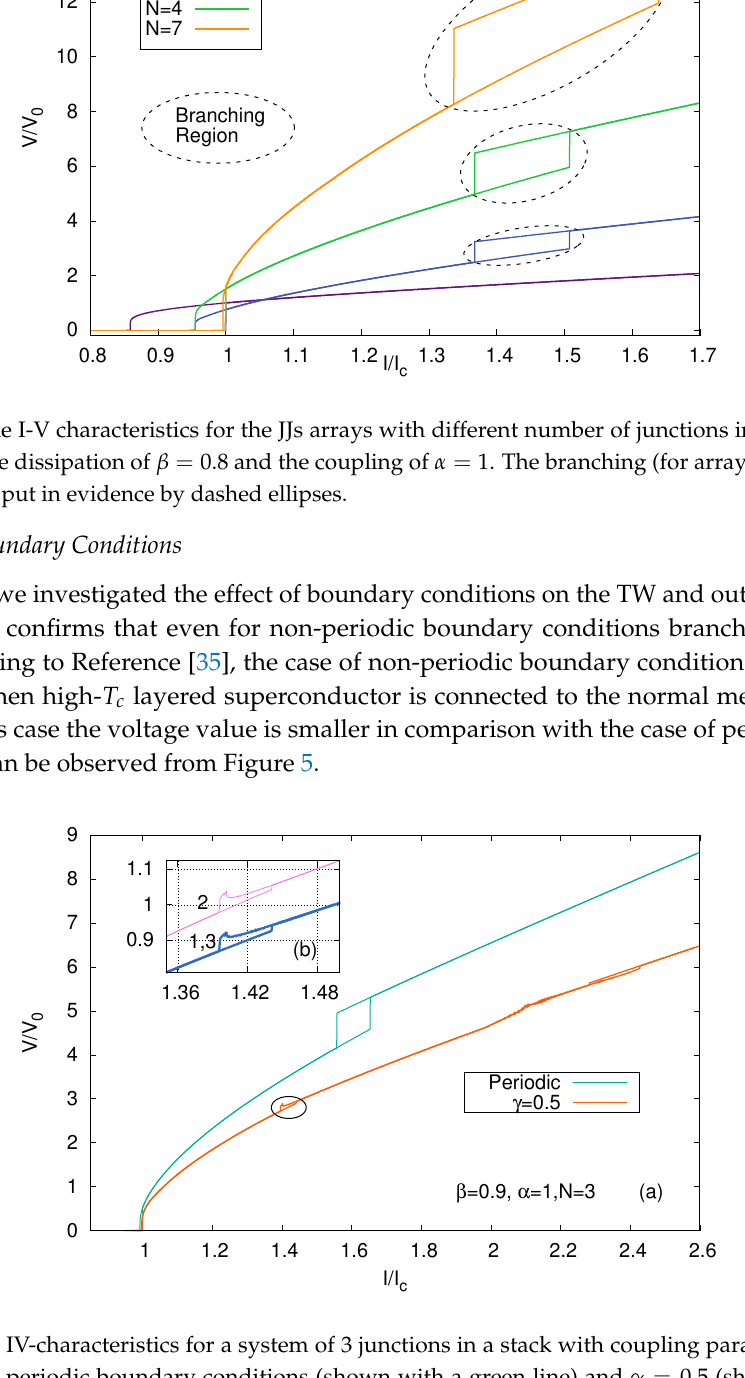
Figure 5. ( a ) IV-characteristics for a system of 3 junctions in a stack with coupling parameter α = 1, β = 0.9 and periodic boundary conditions (shown with a green line) and γ = 0.5 (shown with an orange line). ( b ) Zoom at the IV-characteristic for the region marked by an elipse (currents from 1.36 I c to 1.48 I c ) for junctions 1, 2, and